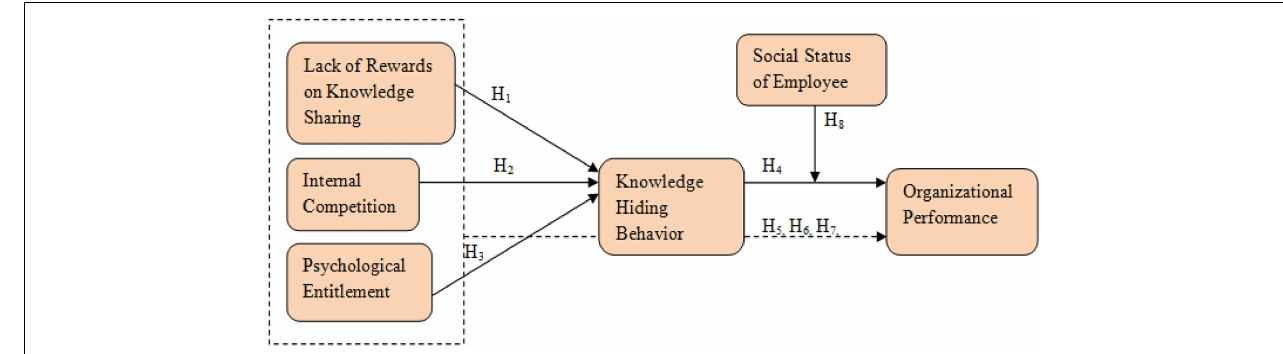
FIGURE 1 | Conceptual